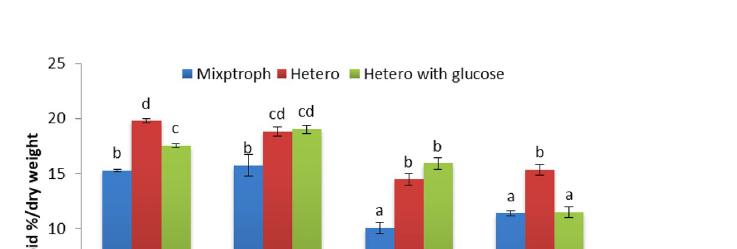
Figure 10. Effect of different pH levels on lipids percentage produced by microgreen alga S. obliquus that grows with Disperse orange 2RL (20 ppm) at different conditions. Par represent standard error, different letters clear the significant result.